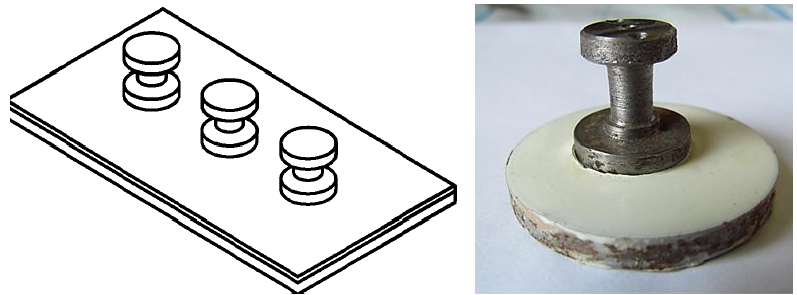
Figure 3. Samples for the adhesion test by dolly application.